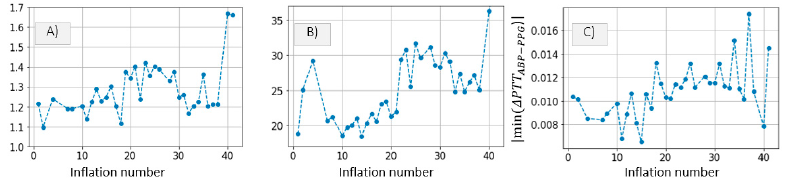
Figure 11. Inference results of the parameters a and c per inflation; ( A ) Patient 1 data and ( B ) Patient 2 data. Blue represents the central tendency of the posterior distribution, gray represents the 95% HDI.